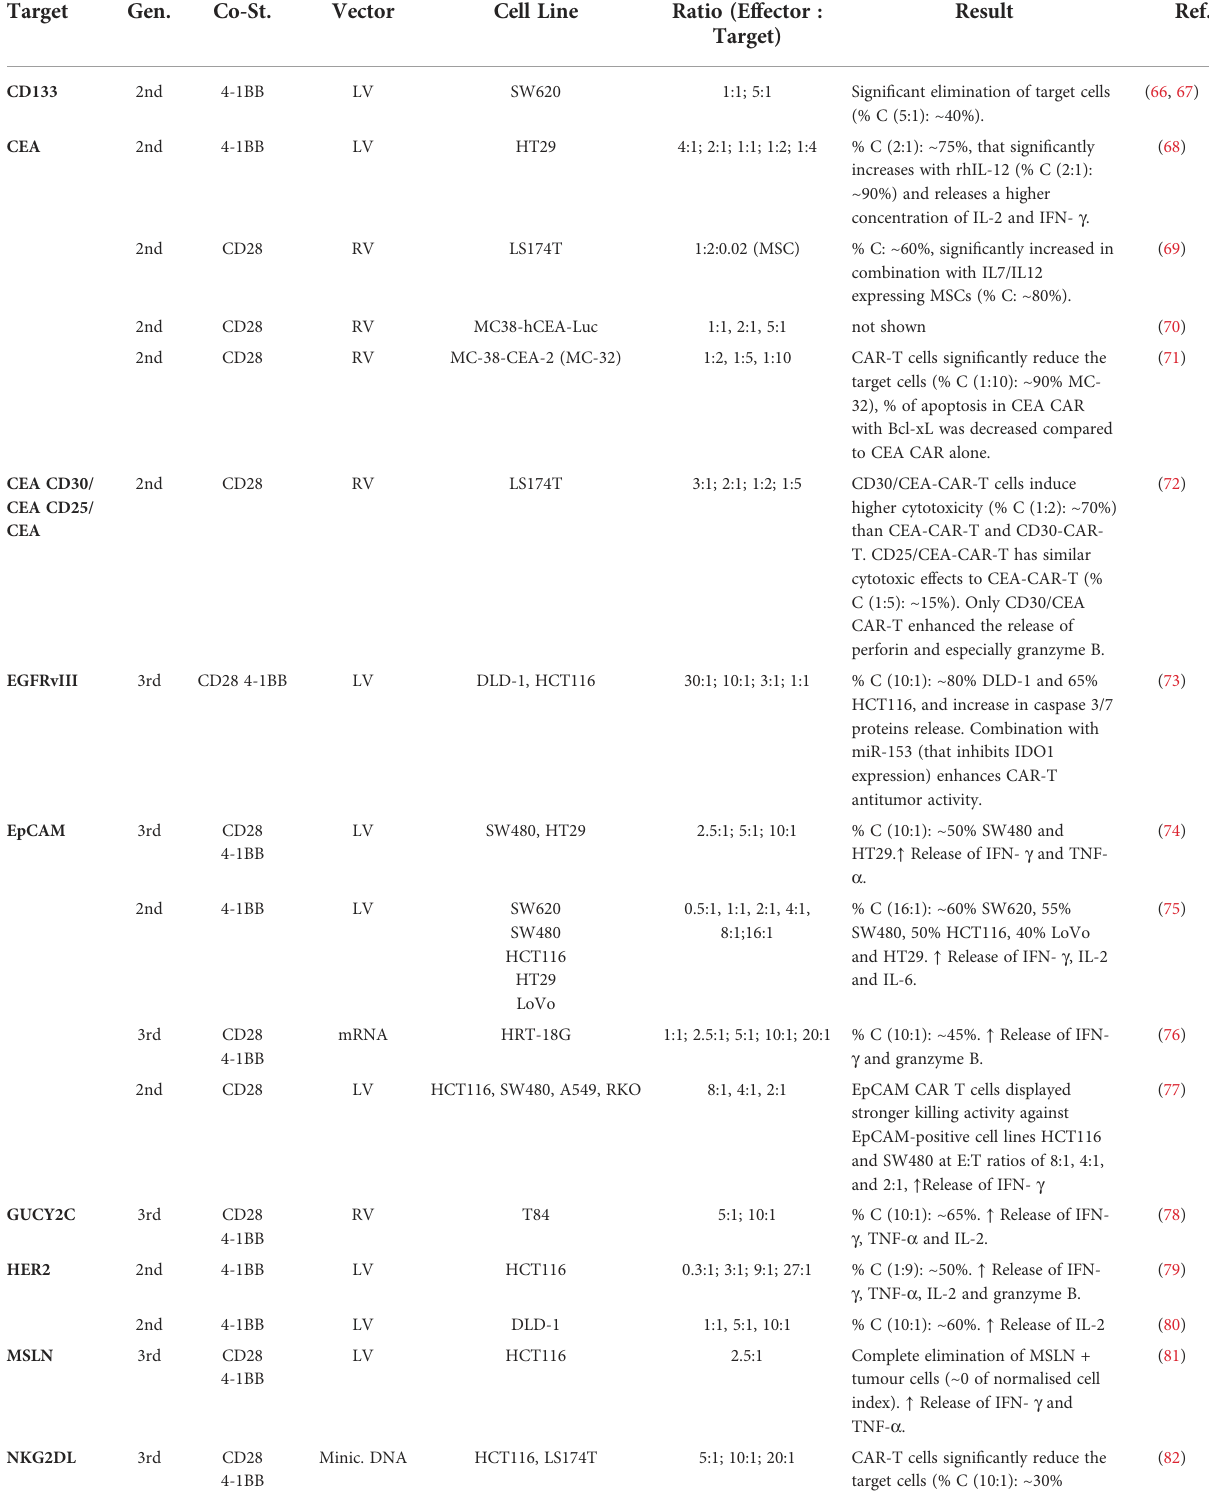
TABLE 1 Antigens targeted by CAR-T cell therapies in CRC and reported in preclinical studies. IN VITRO STUDIES Target Gen. Co-St. Vector Cell Line